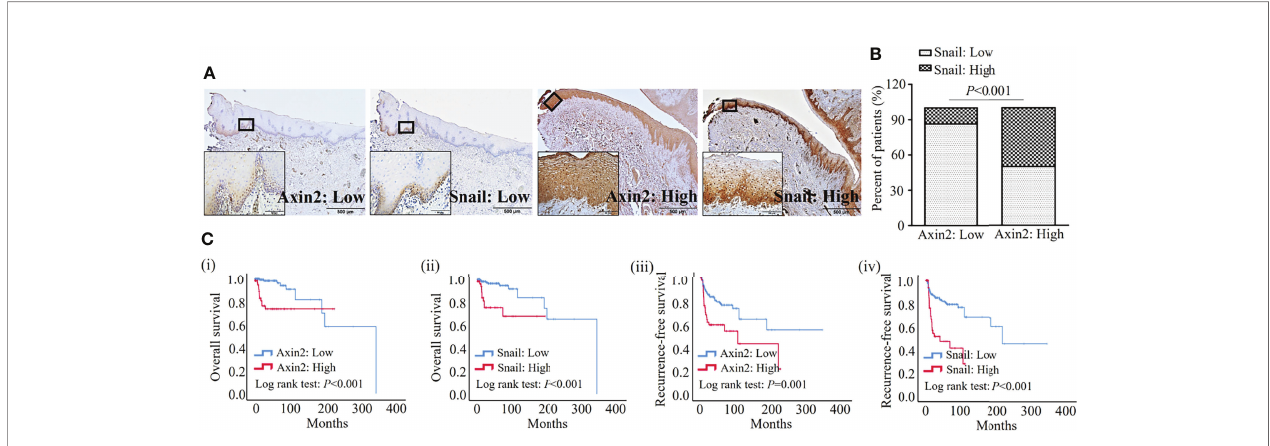
FIGURE 3 | Clinicopathologic signi fi cance of Axin2 and Snail expression in surgical margins from the OSCC cohort. (A) Representative expression patterns for low or high levels of Axin2 and Snail in surgical margins of OSCC; (B) Axin2 and Snail expression showed a signi fi cant correlation in surgical margins of OSCC; (C) Axin2 and Snail expression in surgical margins showed signi fi cant associations with overall and recurrence-free survival in OSCC